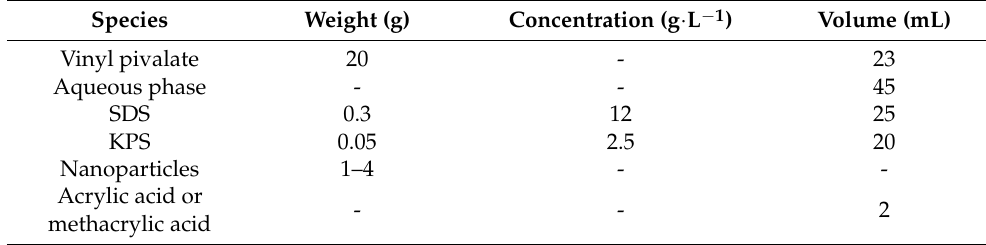
Table 1. Recipe for the in situ synthesis of magnetic poly(vinyl pivalate)